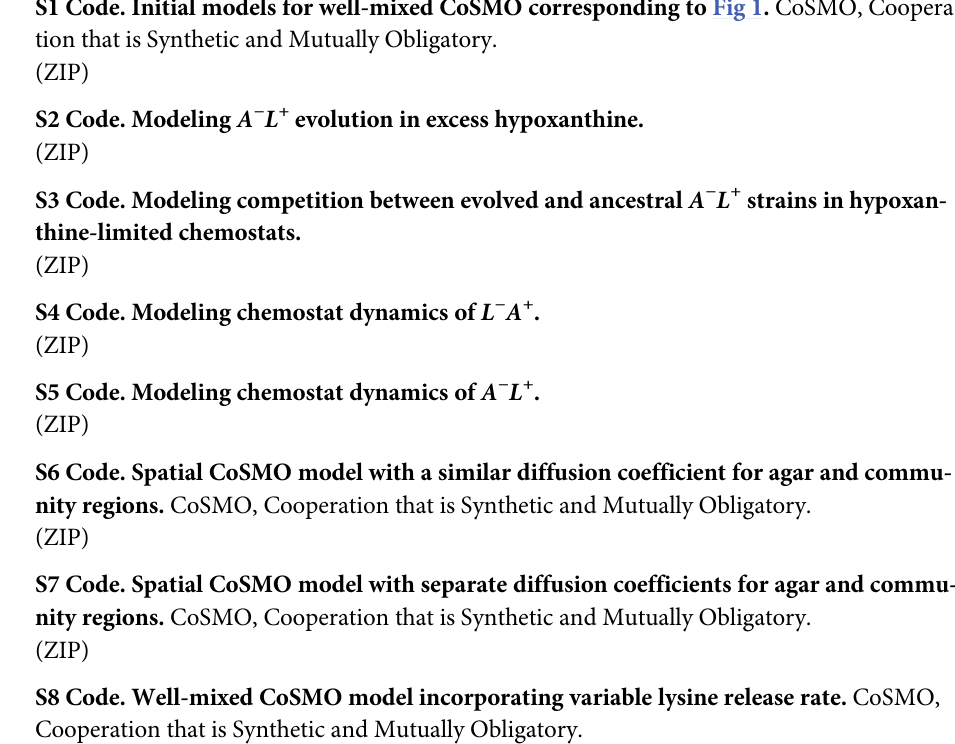
S8 Table. A − L + death and release